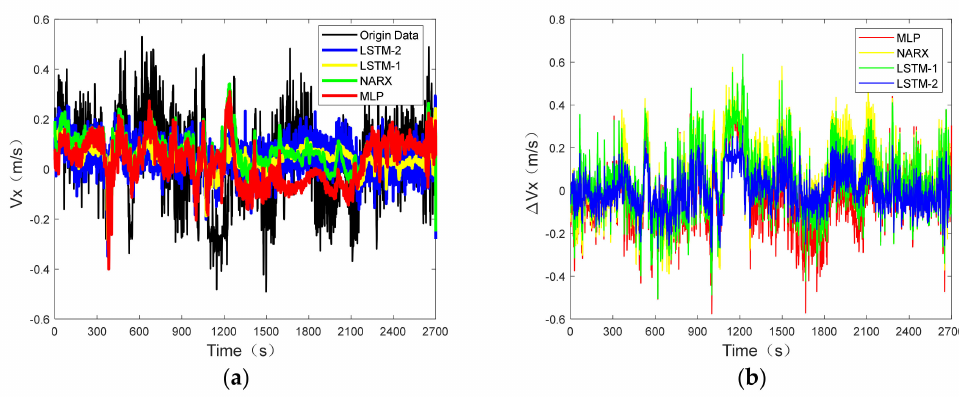
Figure 10. Prediction results of east velocity: ( a ) Comparison of actual value and the predicted velocity in the east; ( b ) The errors of actual value and the predicted velocity in the east for different algorithms.